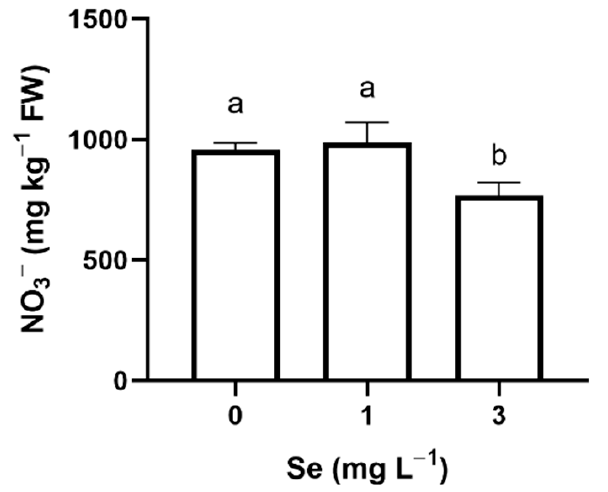
Figure 5. Nitrates (NO 3 − ) content, measured at maturity, in leaves of lettuce plants treated with different concentrations of Se at pre-transplanting. Means ( n = 3) flanked by different letter are statistically different for p = 0.05 after Tukey’s test.